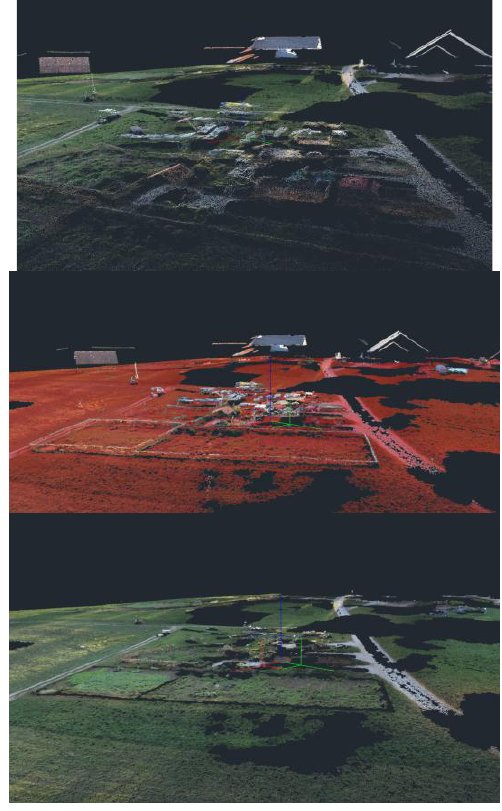
Figure 4. Part of RGB coloured raw photogrammetric point cloud (top), classified point cloud (middle; terrain points in red) and filtered terrain points (bottom)